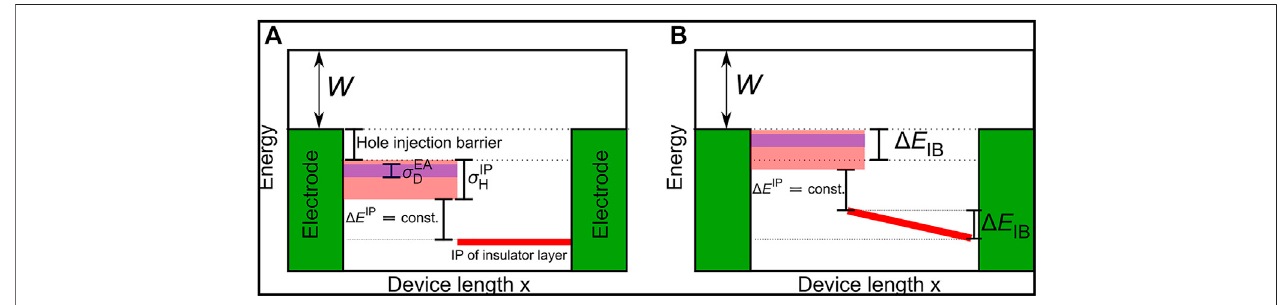
FIGURE 1 | Schematic energy level diagram of the device to measure doping induced injection barrier reduction. The device consists of two identical electrodes withtheworkfunction W (cid:1) 4.5 eVandtwoorganiclayers:thedopedholeinjectionlayer(HIL)andtheholeblockinglayerrighttoit. (A) Thehostionizationpotential(IP) E IP H is indicated by the light red beam with a width indicating the energetic disorder σ IP H . Analogously, the dopant electron af fi nity (EA) with disorder σ EA D is shown by the blue beam. (B) After activation of the host/dopant pairs free charge carriers (here holes) are ejected from the doped HIL into the anode, leaving a negative net charge in the organic layer and causing an upward shift of the energy levels, reducing the injection barrier. The energy levels are shifted until the tail states of the host IP reach the Fermi level of the